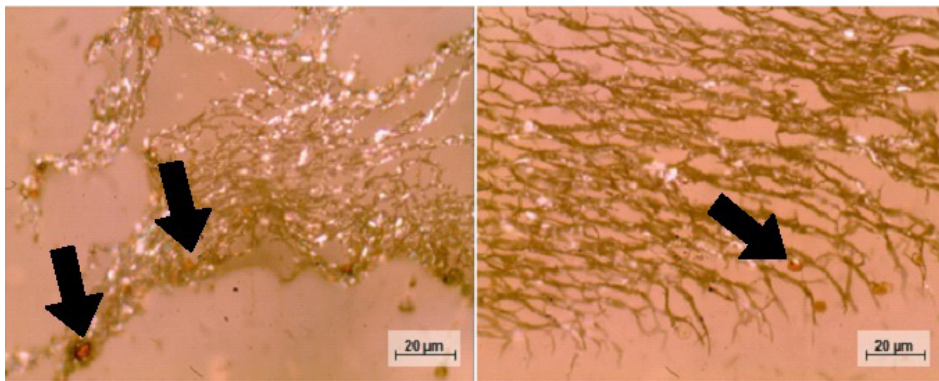
Figure 7. Contaminated blade with 2% left and 5% right. Source: Author’s own elaboration.